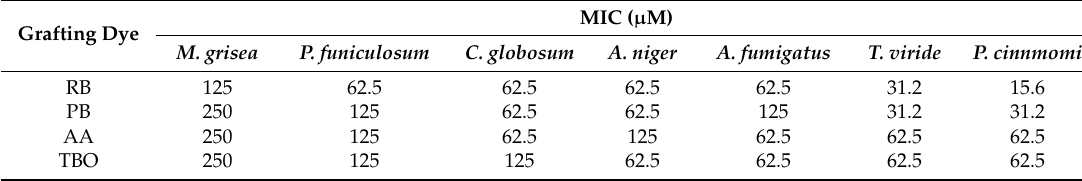
Table 2. The minimum inhibition concentration (MIC) of RB, PB, AA, and TBO to prevent the fungal growth in broth microdilution tests by visual observation (the highest concentration to inhibit growth was selected among three